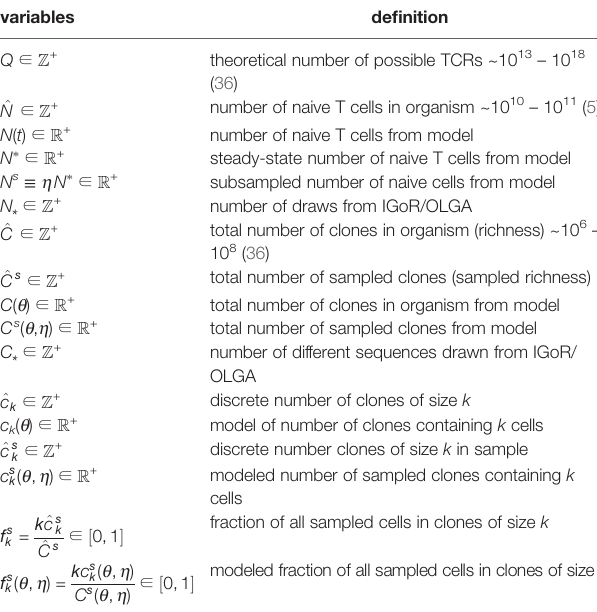
TABLE 2 | Model variables and their de fi